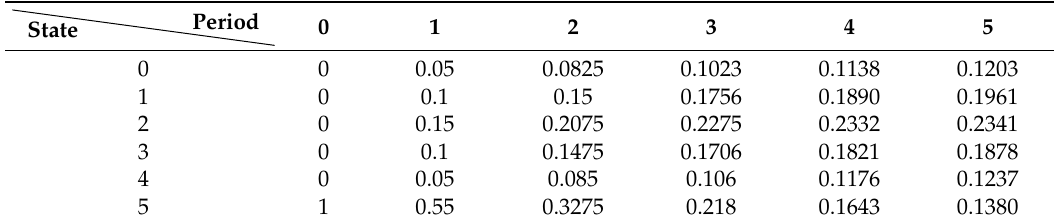
Table A4. Probability distribution of component 4 using the SMV approach.